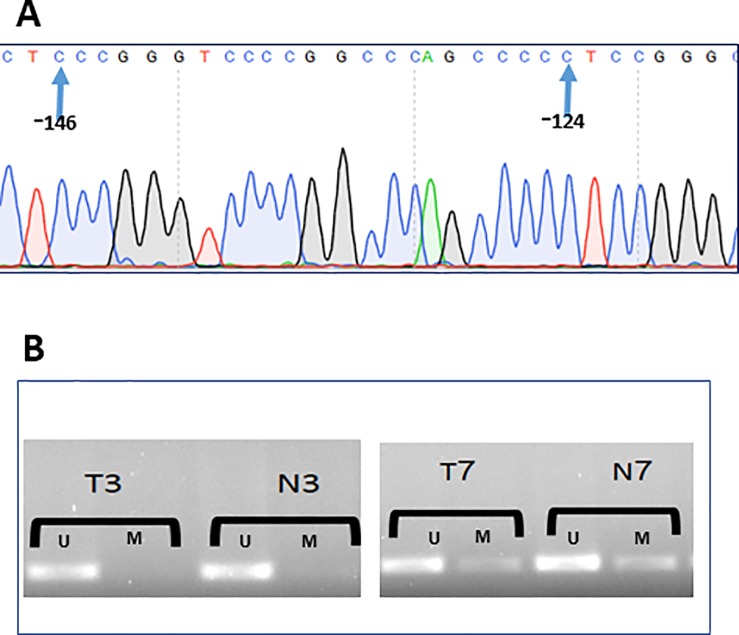
Promoter sequencing and methylation status of hTERT.(A) Chromatogram of a part of hTERT core promoter region, no mutation was detected in any of the samples (n = 24); (B). Majority of samples showed unmethylation n = 13 (Left), some are partially methylated n = 3 (Right), U: Unmethylated; M: Methylated, T: Tumor; N: Adjacent mucosa.